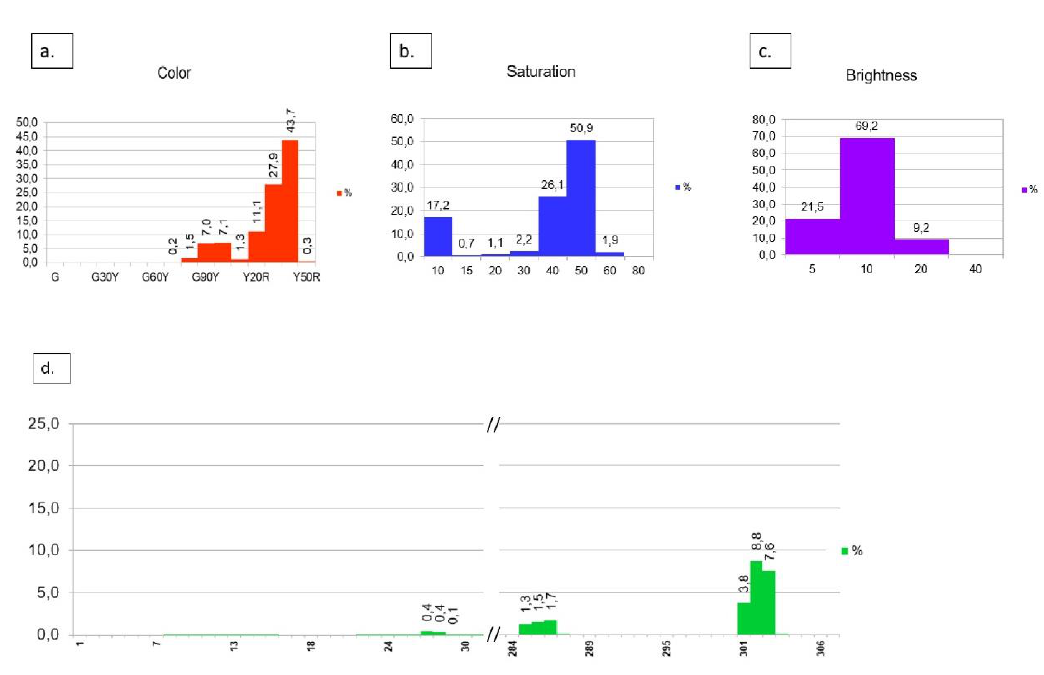
Figure 8. Mango color results as provided by the software WinFoodEval as histograms, ( a ) color, ( b ) saturation, ( c ) brightness according to the HSI classification, ( d ) histogram of color codes according to NCS classification. All pixel values were calculated as a percentage (%) of the total mango surface. (This is a zoom from Figure 6).